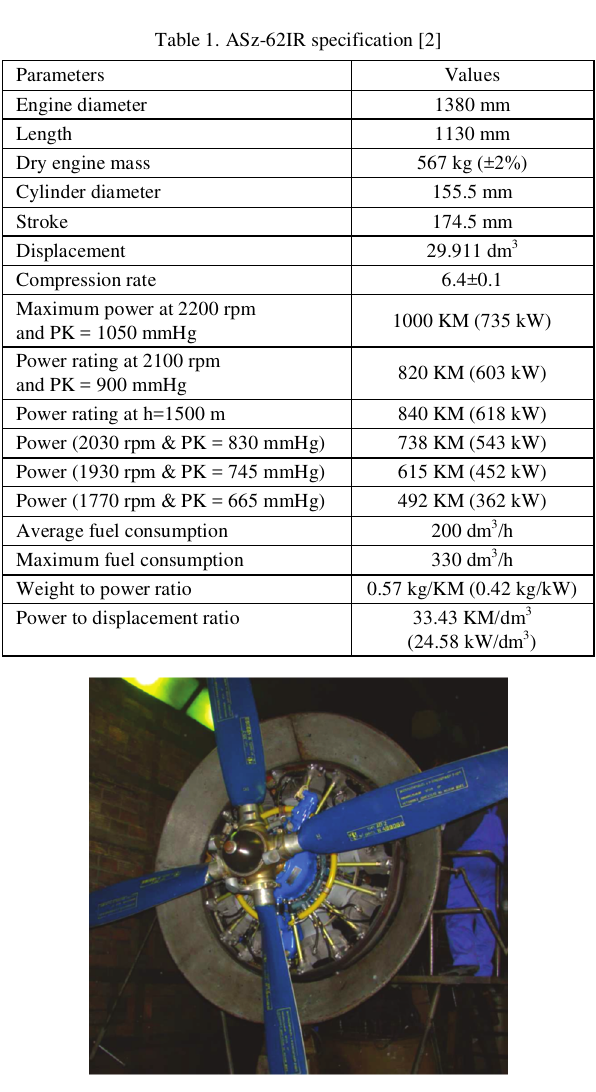
Fig. 1. ASz-62IR-16E engine in test